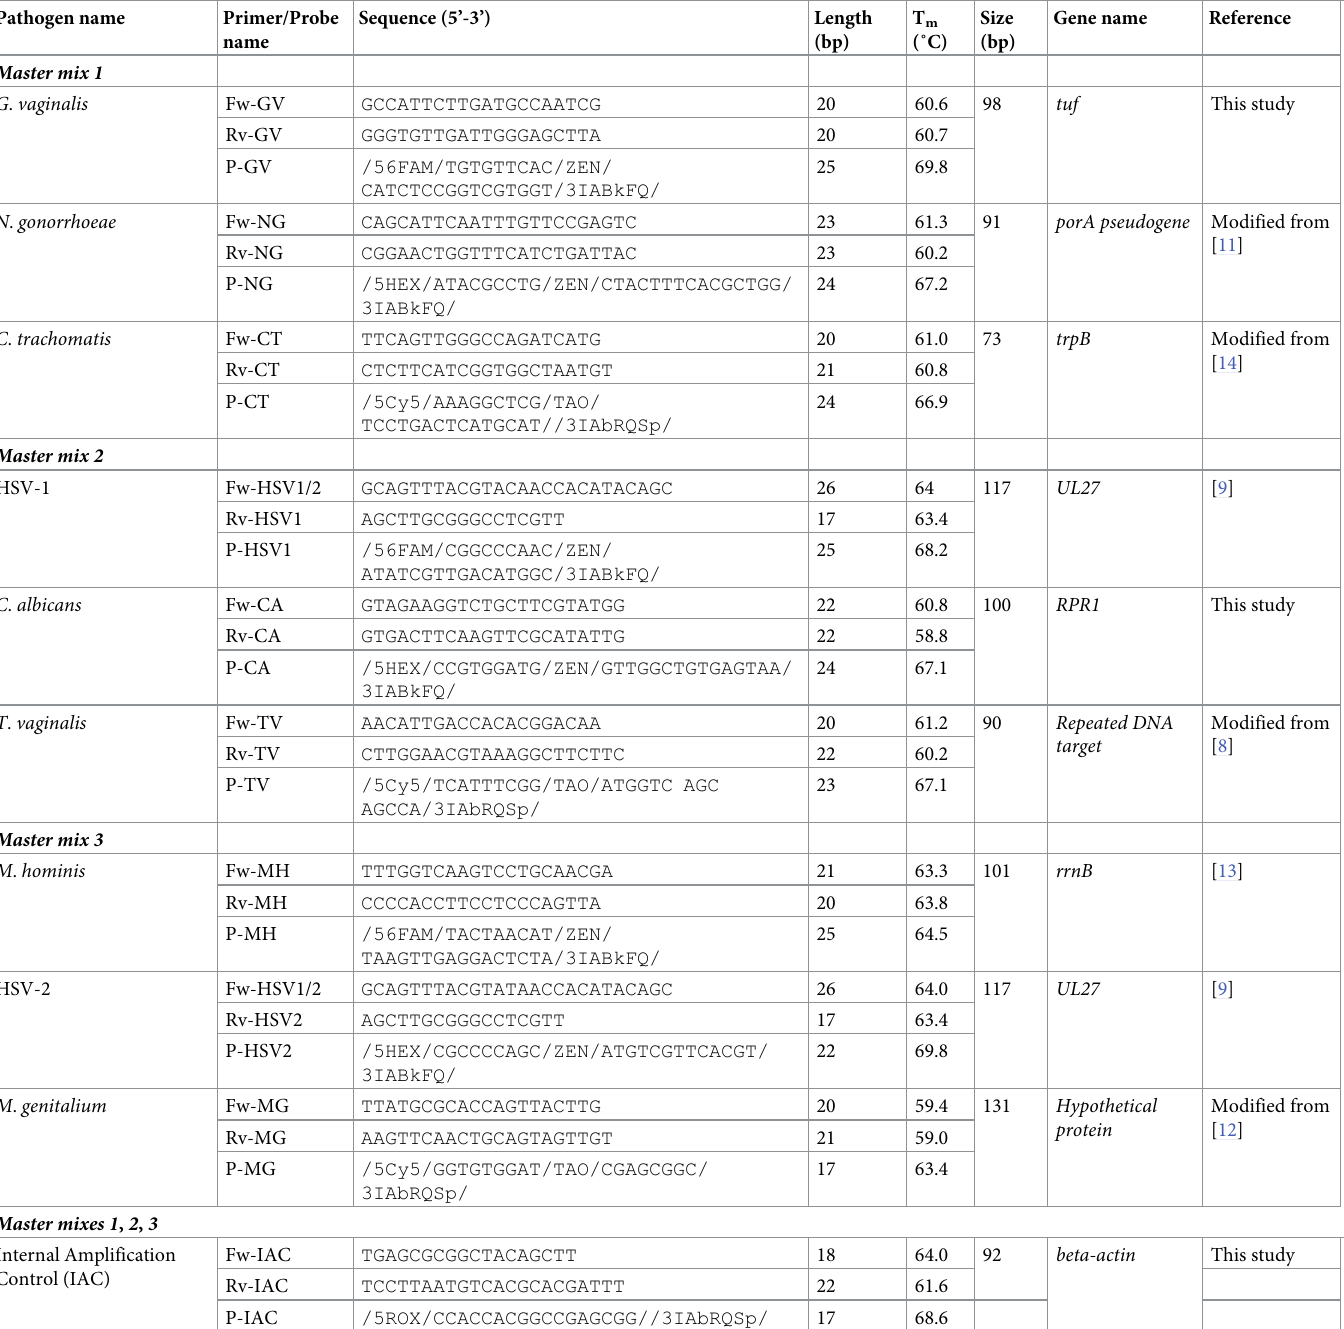
Table 1. Nucleotide sequences of primers and probes for nine STIs and internal control. Pathogen